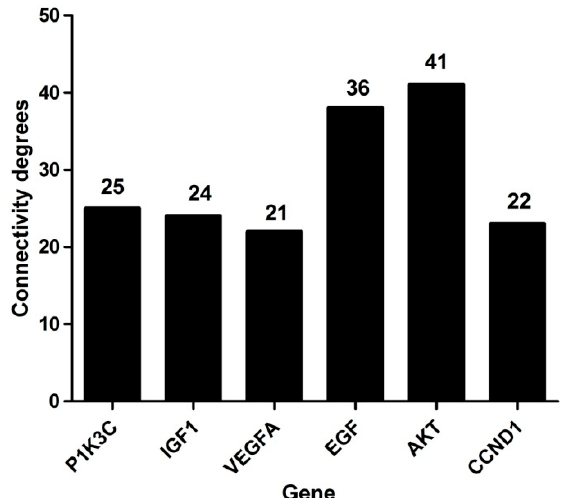
Figure 4. Connectivity degrees of the Protein-protein interactions (PPI) network.